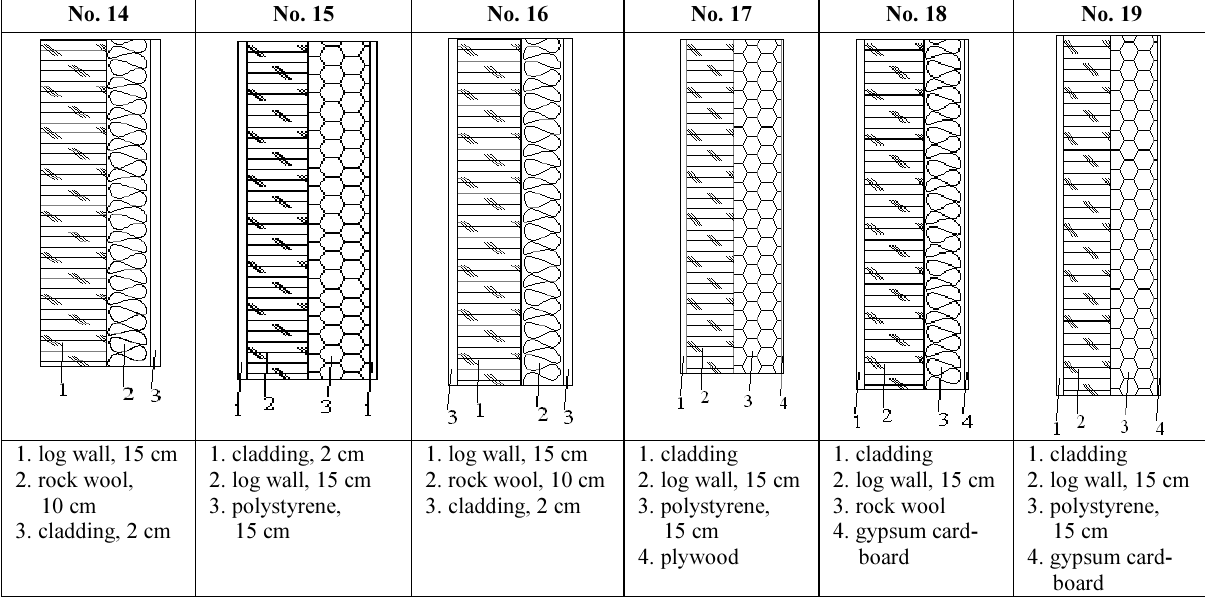
Fig. 9. Structures of experimental specimens of the log